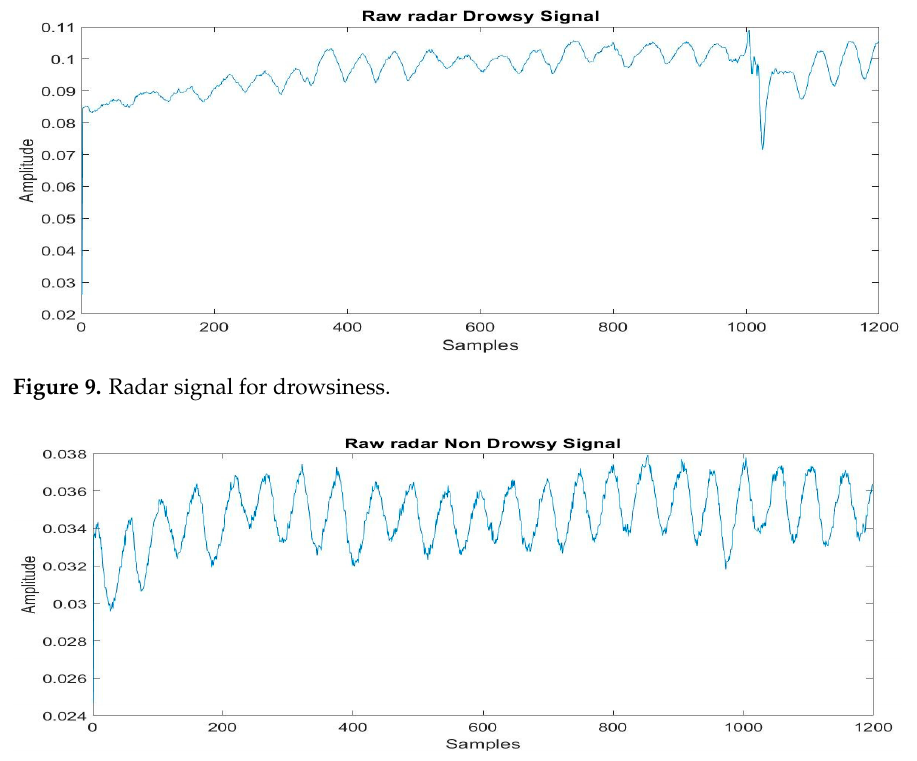
Figure 10. Radar signal for non-drowsiness.